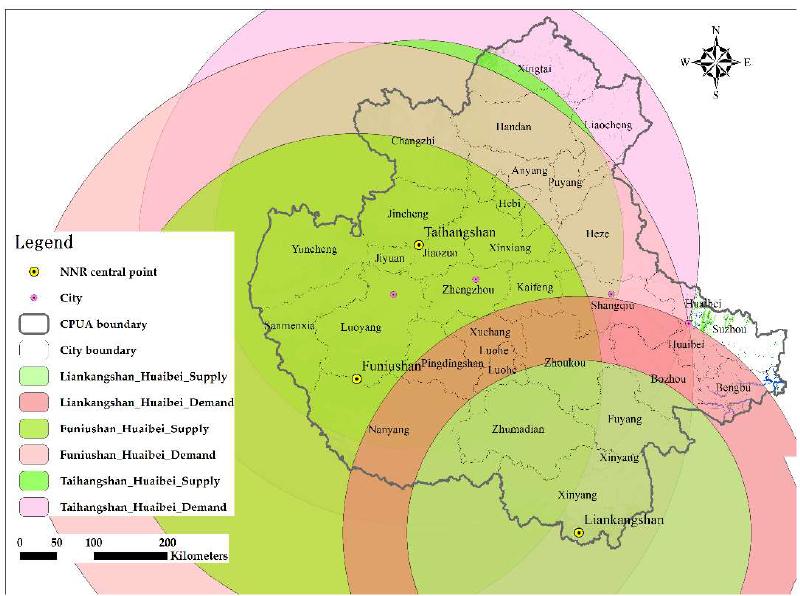
Figure 6. ES supply and demand patterns based on spatial transfer from ecospace to Huaibei.